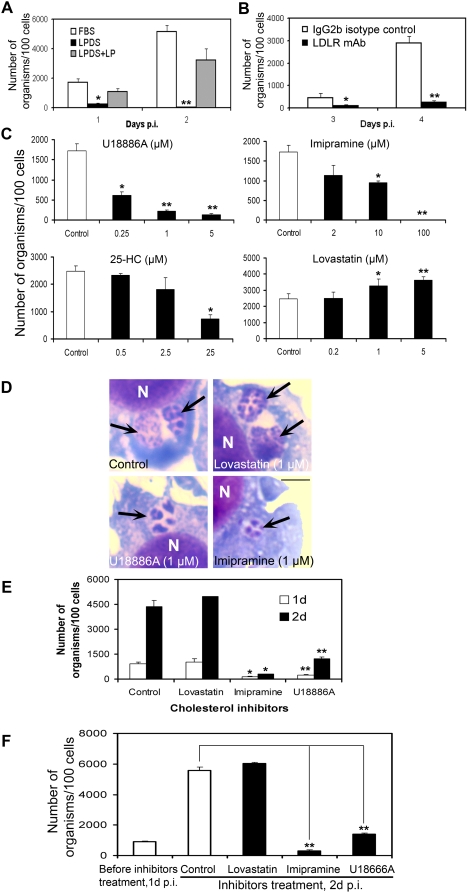

A. phagocytophilum infection requires cholesterol derived from the host LDL uptake pathway rather than de novo biosynthesis.(A) A. phagocytophilum growth in HL-60 cells cultured in the growth medium containing lipoprotein deficient serum (LPDS), LPDS reconstituted with lipoproteins (LP), and fetal bovine serum were determined on days 1 and 2 p.i. (B) HL-60 cells were pre-treated with anti-LDLR mAb and isotype control mouse IgG and infected with host cell–free A. phagocytophilum. The number of bacteria was determined on days 3 and 4 p.i. (C) Cholesterol transport and biosynthesis inhibitors U18886A, imipramine, 25-hydroxycholesterol (25-HC), and lovastatin were added at 1 h p.i. at different dosages, and numbers of bacteria were determined on day 2 p.i. Data are expressed as mean±standard deviation (n = 3) and are representative of two independent experiments with similar results. *, p<0.05 (unpaired two-tailed t test); **, p<0.01 (unpaired two-tailed t-test). (D) A. phagocytophilum-infected HL-60 cells at 1 h p.i. were treated with lovastatin (1 µM), U18886A (1 µM), imipramine (20 µM), and DMSO vehicle control, respectively. On day 1 p.i., infected cells were harvested and observed by light microscopy following Diff-Quik staining. Arrows indicate A. phagocytophilum inclusions. Note much smaller sizes of inclusions that contain much fewer numbers of bacteria in U18886A- or imipramine-treated cells than those in untreated or lovastatin-treated cells. N, nucleus. All figures are shown at the same magnification. Bar, 5 µm. (E) Cultures were treated as in (C), and numbers of bacteria were determined on days 1 and 2 p.i. *, p<0.05 (unpaired two-tailed t test); **, p<0.01 (unpaired two-tailed t-test). (F) Lovastatin (1 µM), U18886A (5 µM), imipramine (100 µM), and vehicle control were added to A. phagocytophilum-infected HL-60 on day 1 p.i. (∼40% infected cells), and the number of bacteria was determined on day 2 p.i. Data are expressed as mean±standard deviation (n = 3) and are representative of three independent experiments with similar results. *, p<0.05 (unpaired two-tailed t test); **, p<0.01 (unpaired two-tailed t-test).